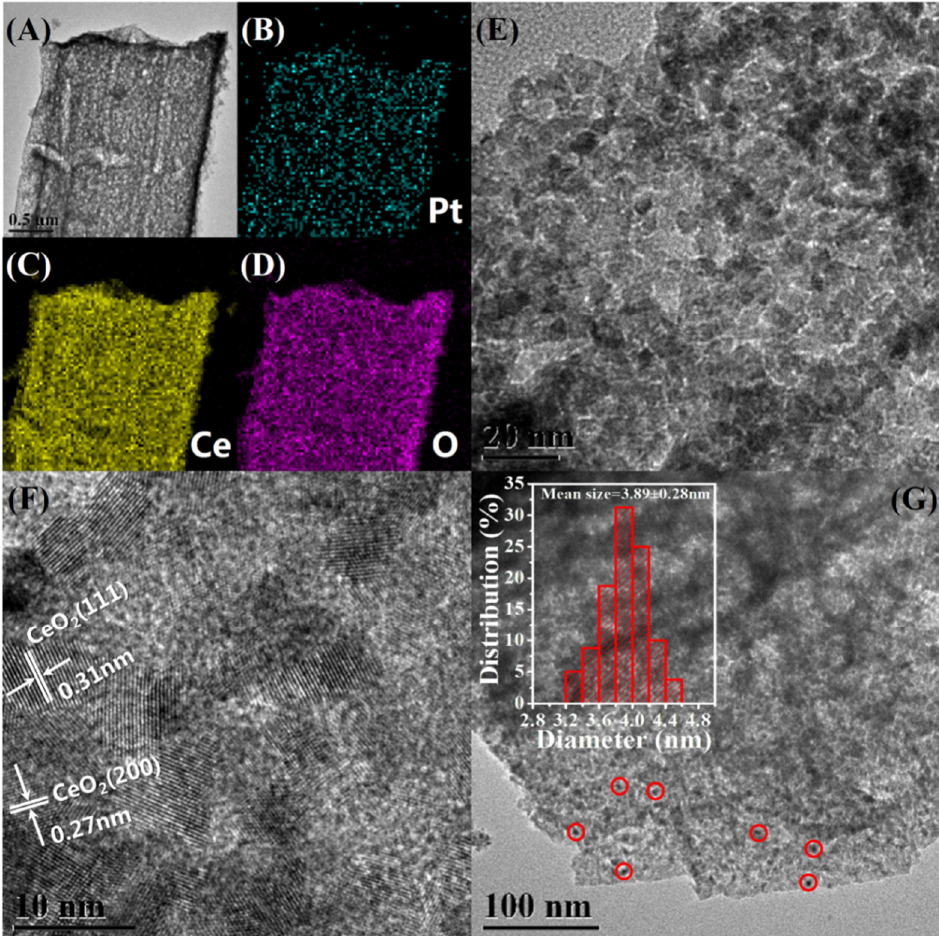
Figure 2. Morphology and structure of Pt(EG)@CeO 2 (Air). ( A , E ) TEM images, ( F ) HRTEM images, ( G ) the distribution of Pt NPs and the inset is histogram of the size distribution of Pt NPs, ( B – D ) EDX elemental mapping images of Pt, Ce, and O, respectively.